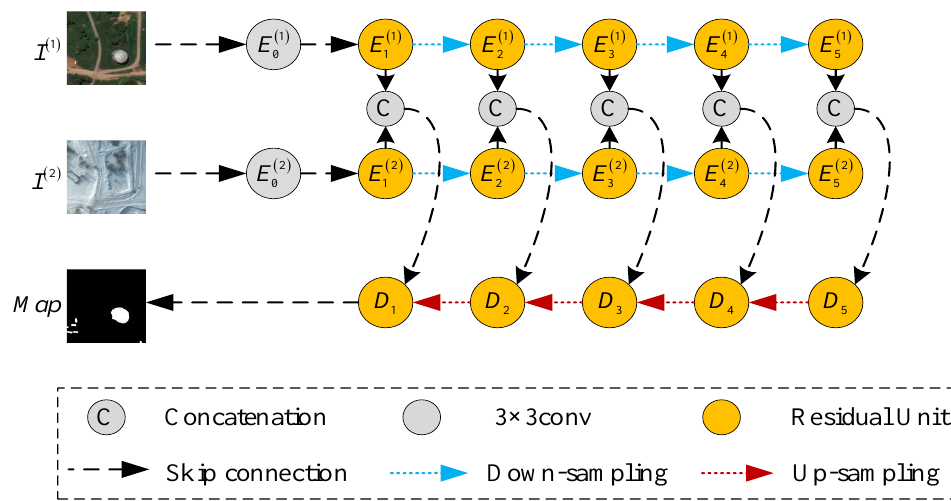
Figure 8. The plain siamese network.